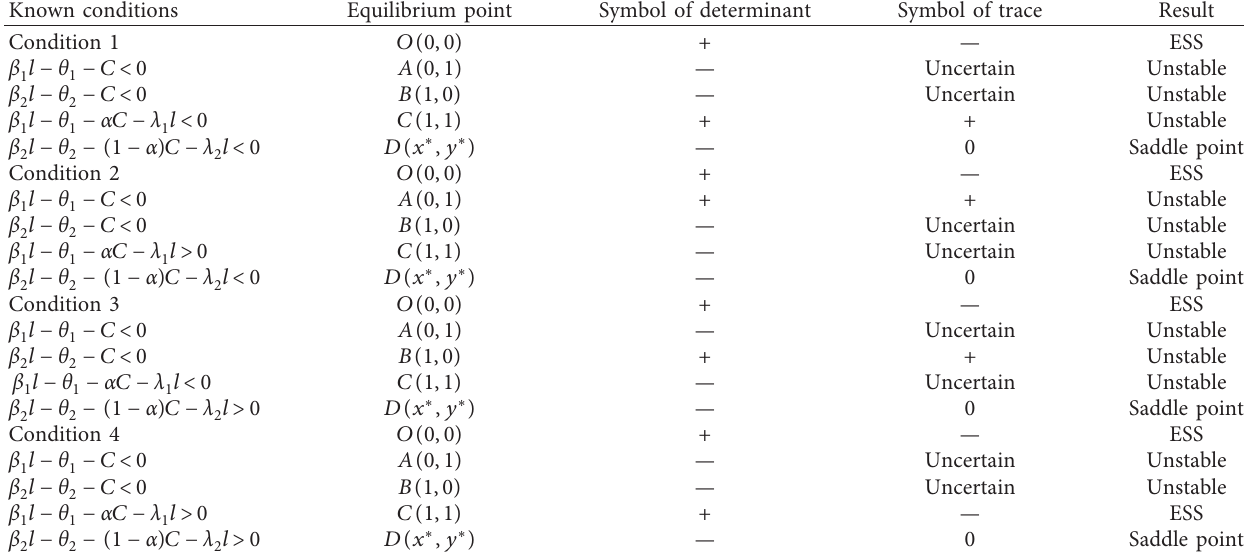
Table 4: Stability analysis of equilibrium